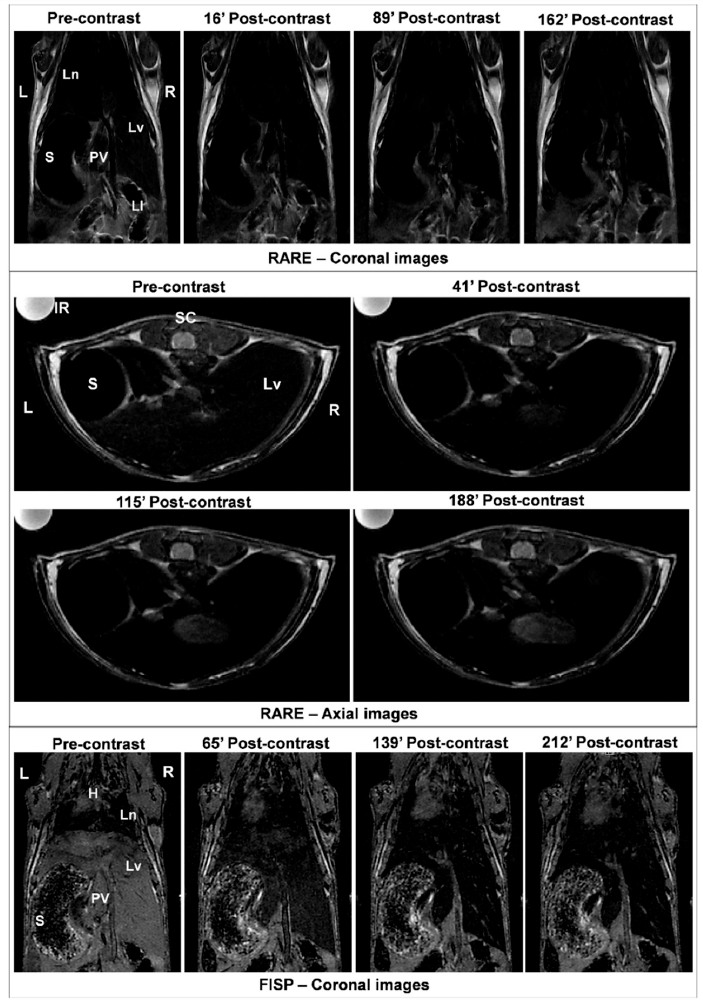
Figure 5. MRI images (coronal and axial RARE, and coronal FISP) of the mouse body acquired with a T 2 -weighted spin-echo sequence before injection (precontrast) and after injection of MNP-DSPE-PEG (postcontrast) at a dose of 100 µmoles Fe/kg bw, at different time intervals. Abbreviations: L: left, R: right, Ln: lungs, S: stomach, PV: portal vein, Lv: liver, LI: large intestine, SC: spinal cord, H: heart.